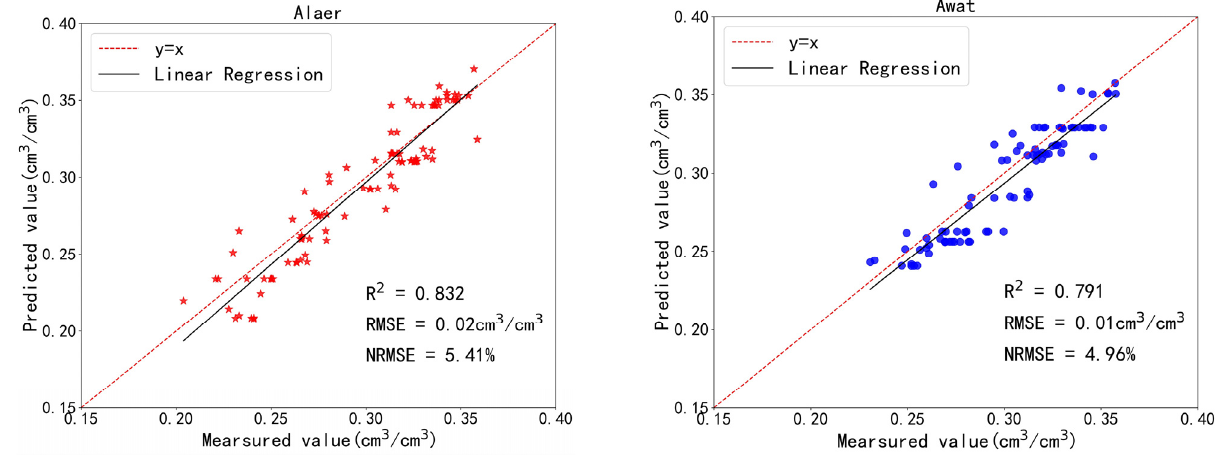
Figure 8. Measured versus simulated soil moisture for different treatments based on modified model.